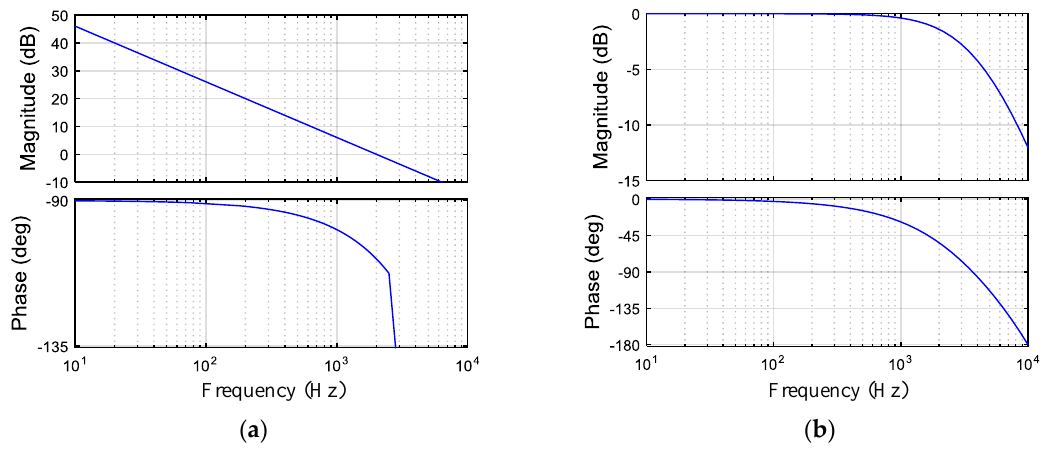
Figure 6. Bode diagrams of the current loop with continuous control when τ = 1.59 T s : ( a ) Open-loop Bode diagrams; ( b ) Close-loop Bode diagrams.